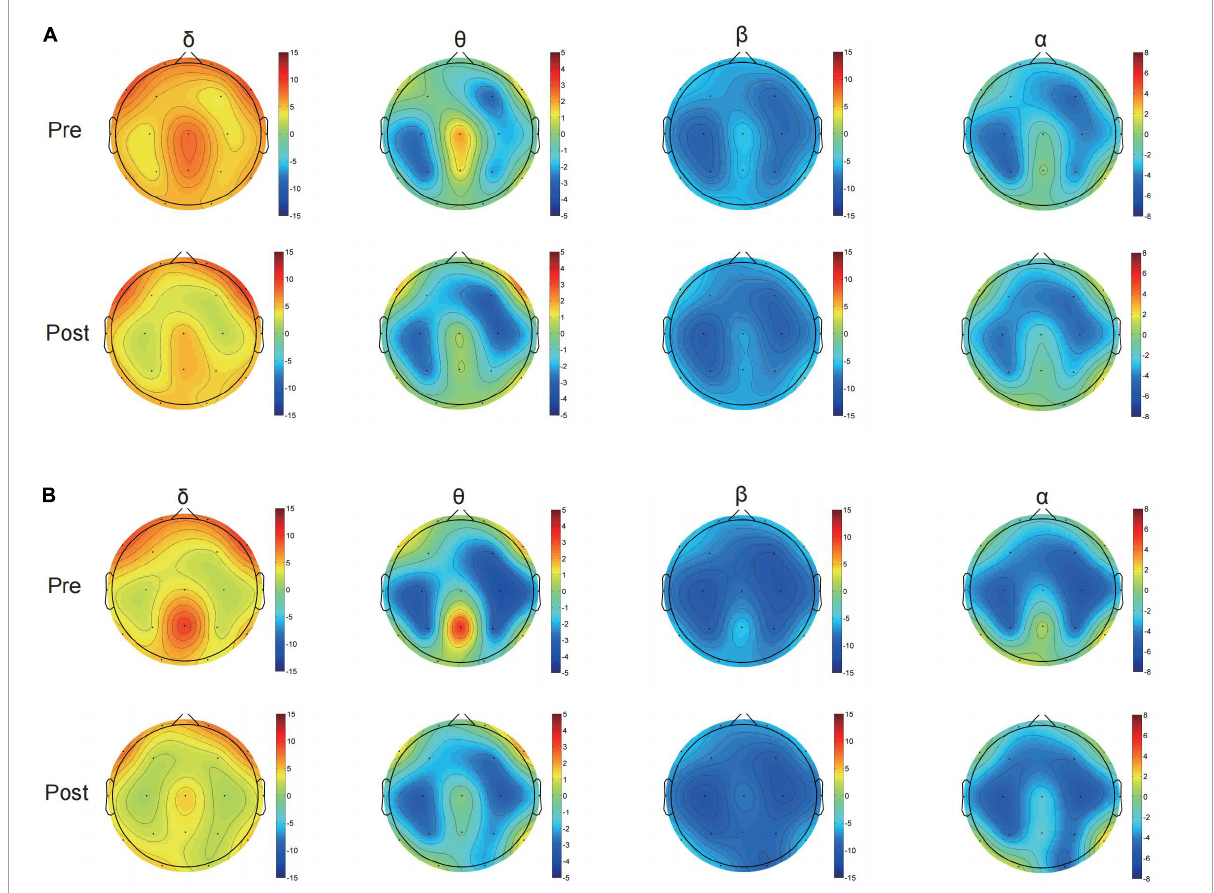
FIGURE9 Power spectral density before and after treatment in the (A) control and (B) Qigong